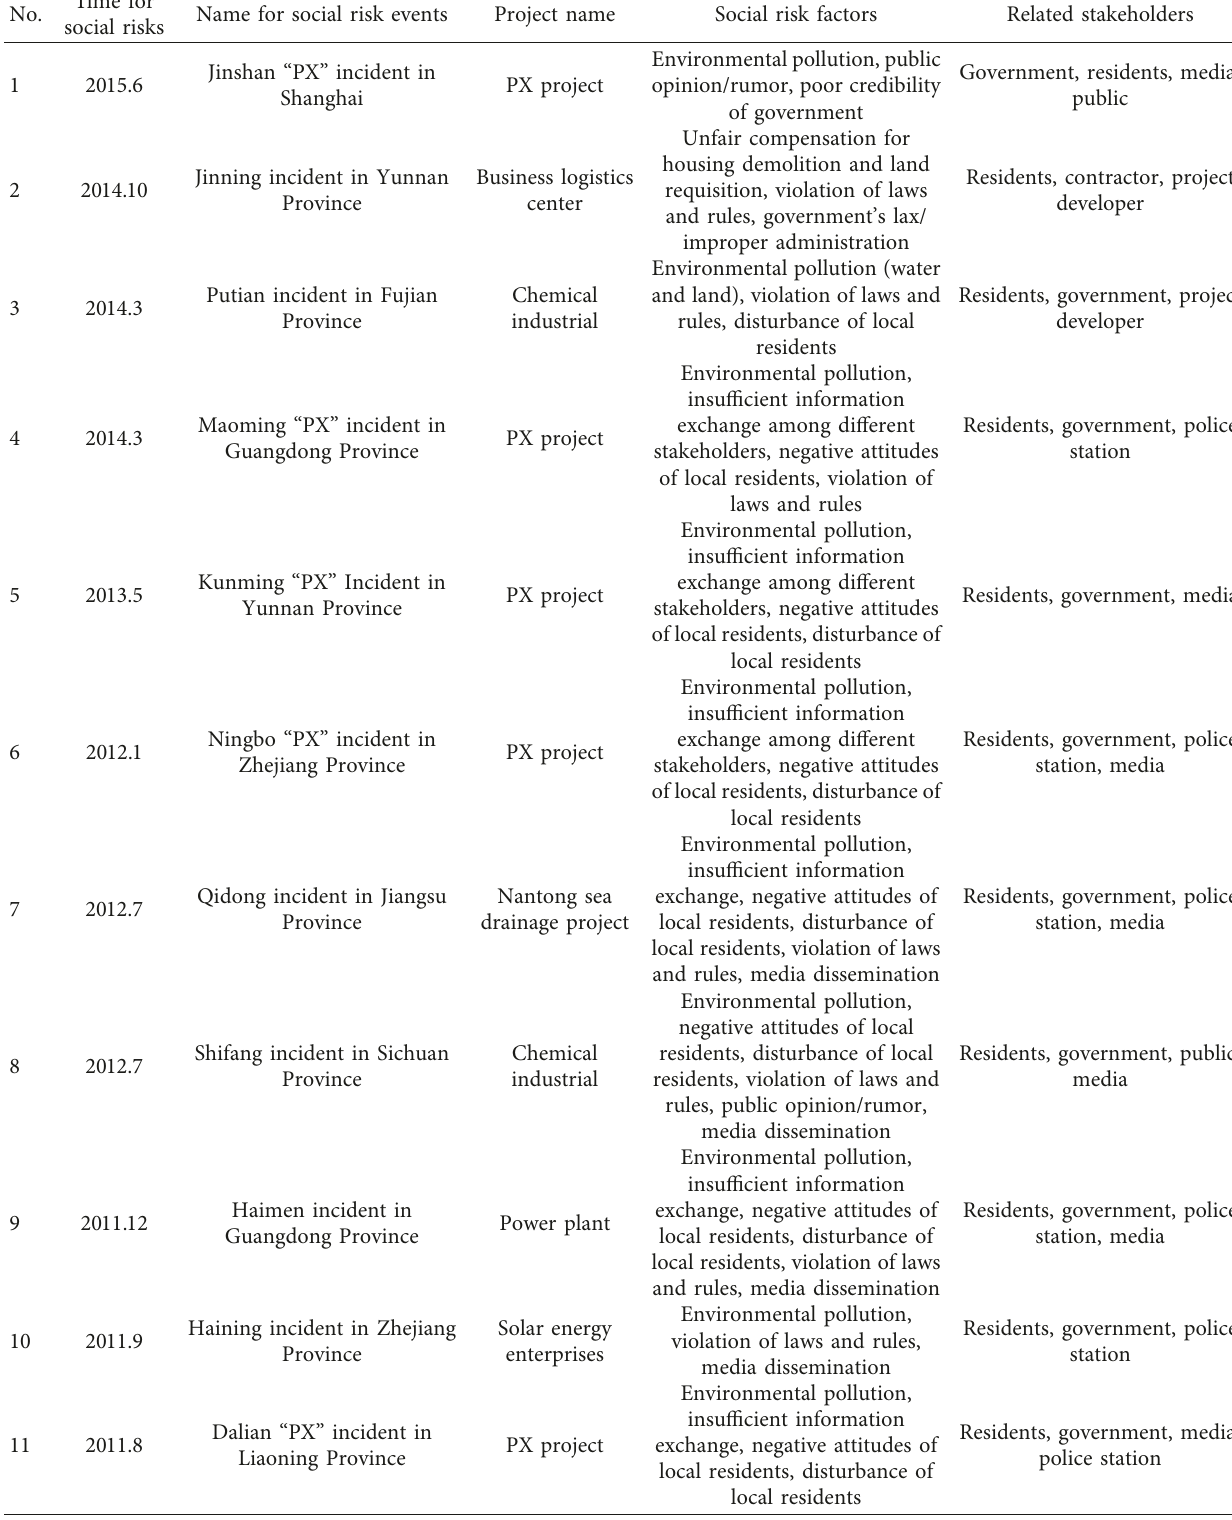
Table 1: Cases lists for the identification of social